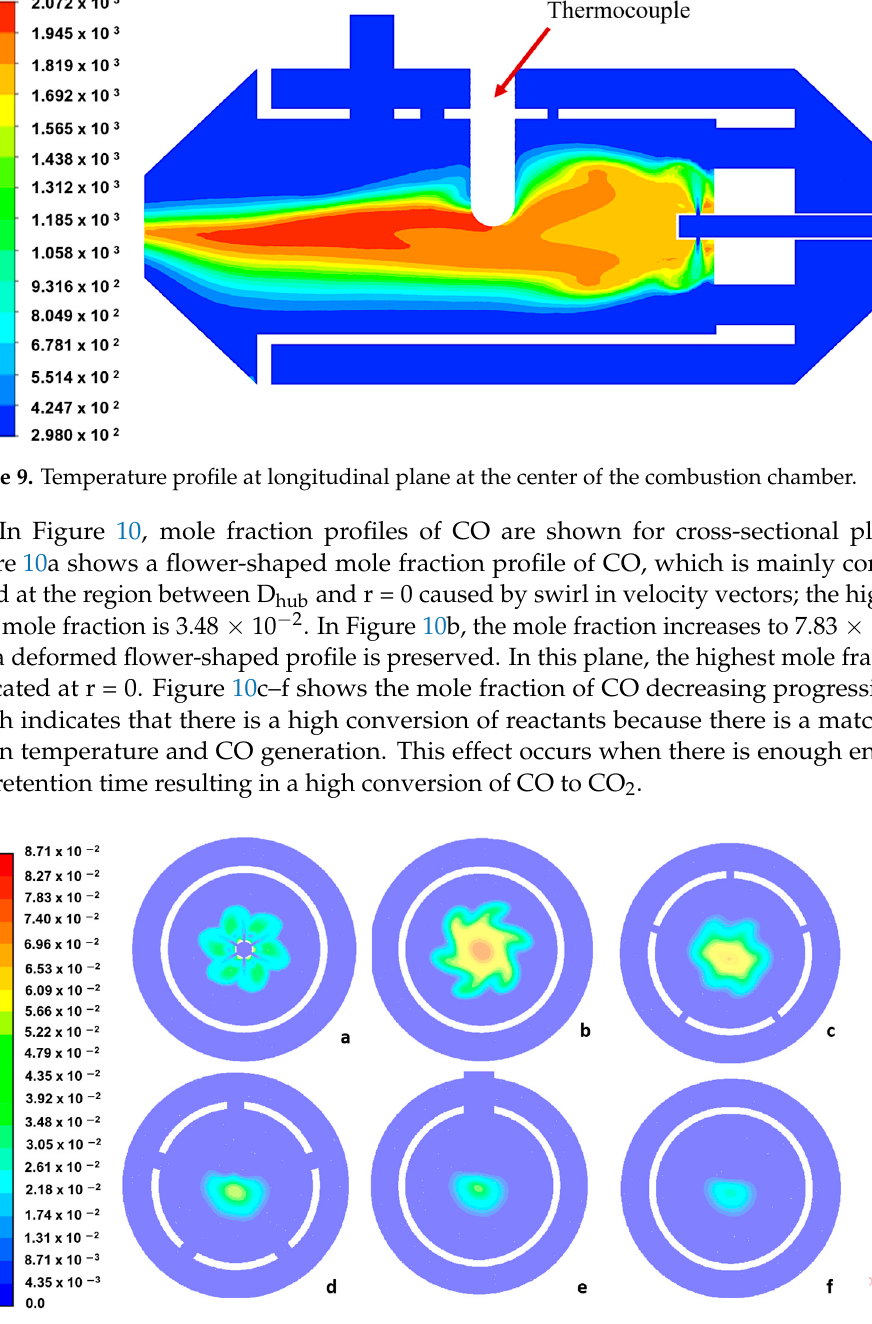
Figure 8. Temperature profiles at transverse plane of the combustion chamber: ( a ) plane 1; ( b ) plane 2; ( c ) plane 3; ( d ) plane 4; ( e ) plane 5; ( f ) plane 6.